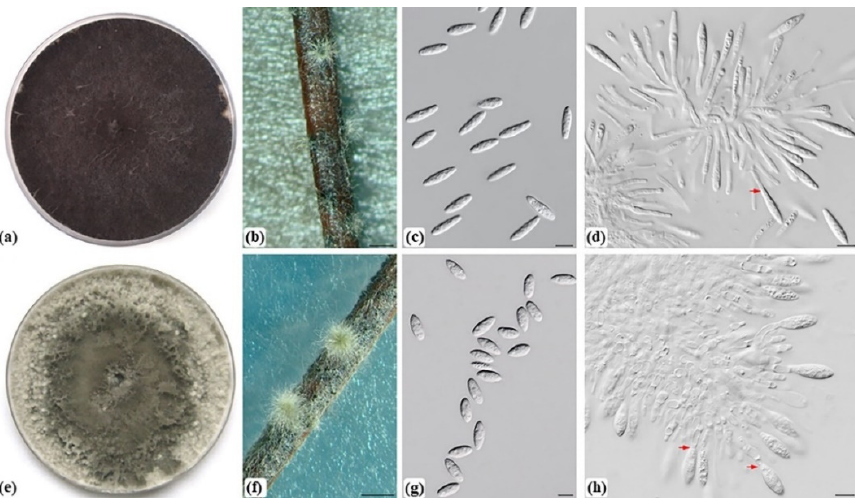
Figure 2. Morphological characteristics of Botryosphaeria dothidea (ILFE 2) and Neofusicoccum yun- nanense (ILFE 4) isolated and identified in this study. ( a , e ). 14-day old culture of B. dothidea ( a ) and N. yunnanense ( e ) growing on MEA at 25 ◦ C. ( b , f ). Superficial globose pycnidia of B. dothidea ( b ) and N. yunnanense ( f ) covered with mycelium. ( c ). Hyaline, aseptate fusiform conidia of B. dothidea . ( d , h ). Conidia of B. dothidea ( d ) and N. yunnanense ( h ) developing on conidiogenous cells. Annellations are marked with arrows ( d , h ). ( g ). Hyaline, aseptate, fusiform to ellipsoidal conidia of N. yunnanense . Scale bars: 1 mm ( b , f ), 10 µ m ( c , d , g , h